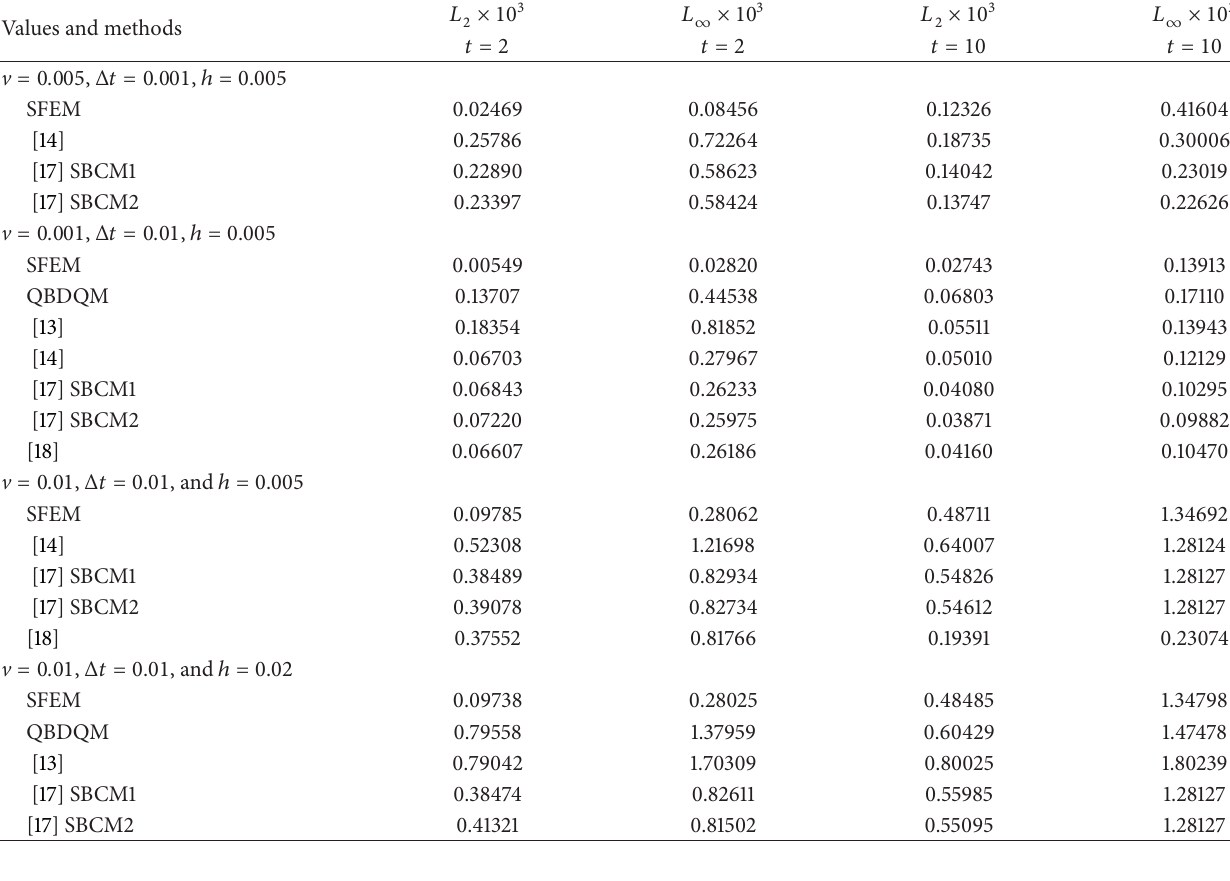
Table 9: Comparison of our results with earlier studies.